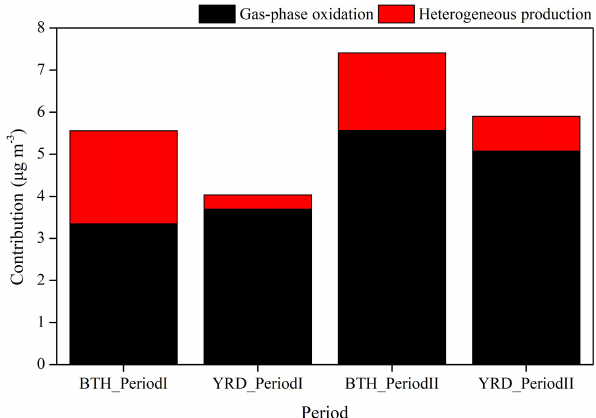
Figure 6. Contributions of gas-phase oxidation and heterogeneous production to the surface nitrate concentrations for the BTH and YRD regions in two